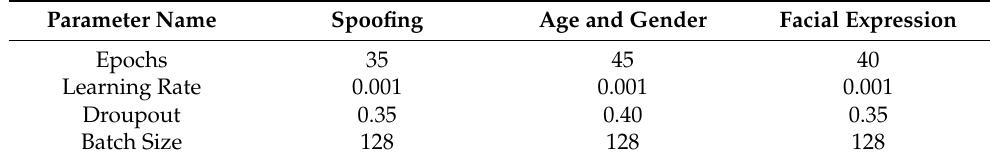
Table 3. Details of Alex-Net Classifier